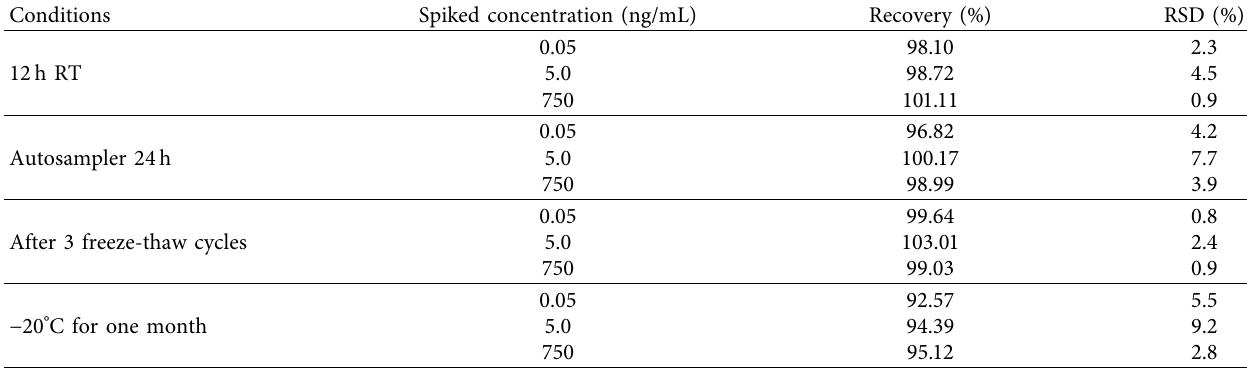
Table 5: Summary of stability of QC samples of liensinine under different storage conditions ( n � 3 ).